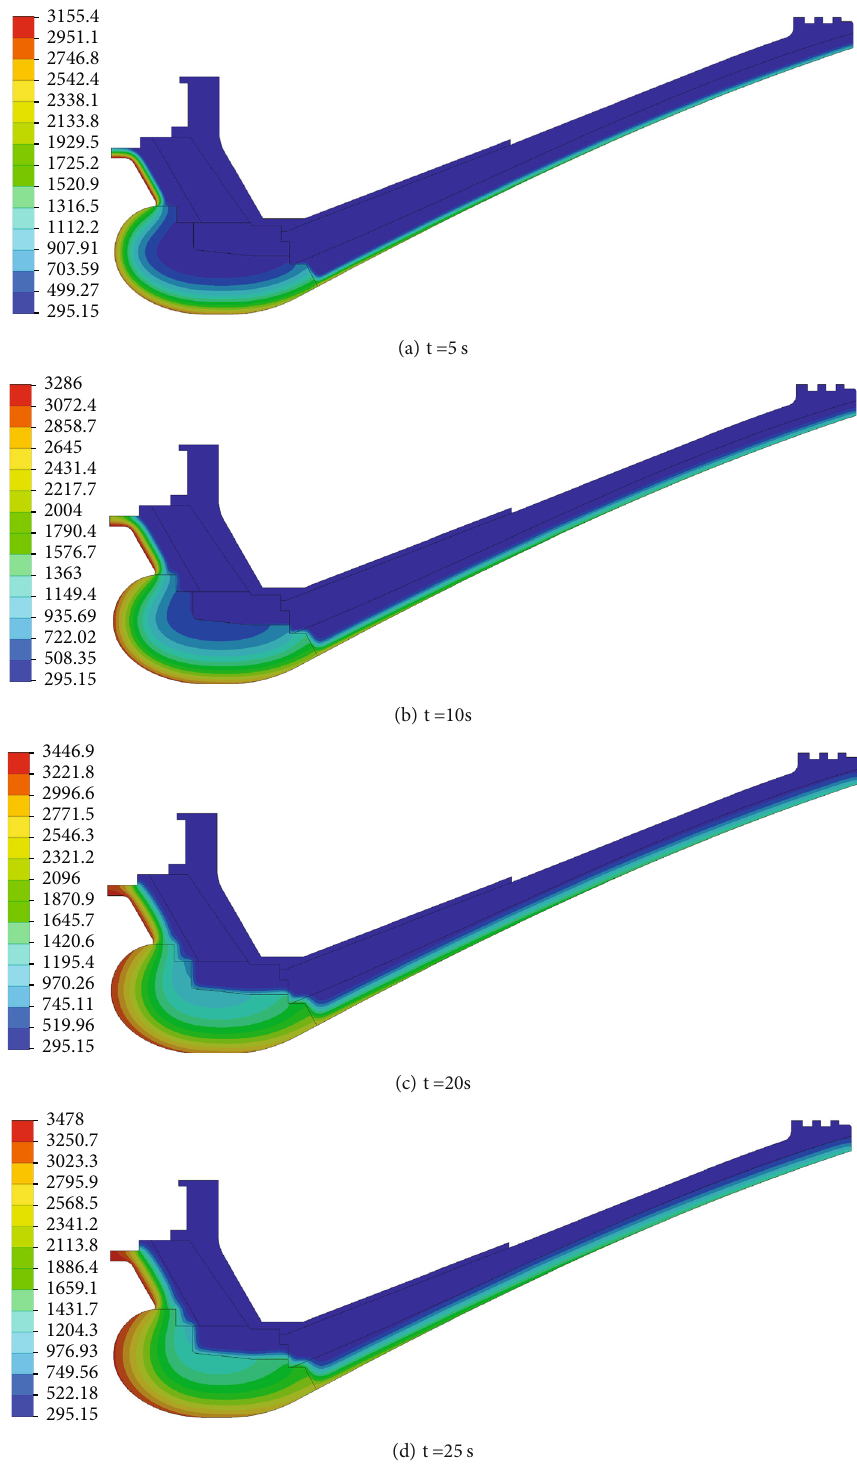
Figure 12: Graphs of temperature distributions